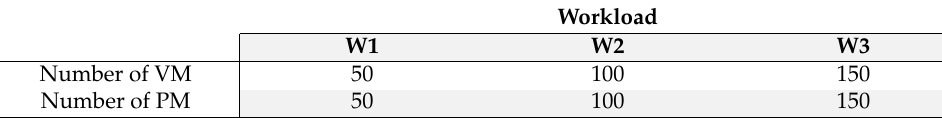
Table 1. Experimental cases.